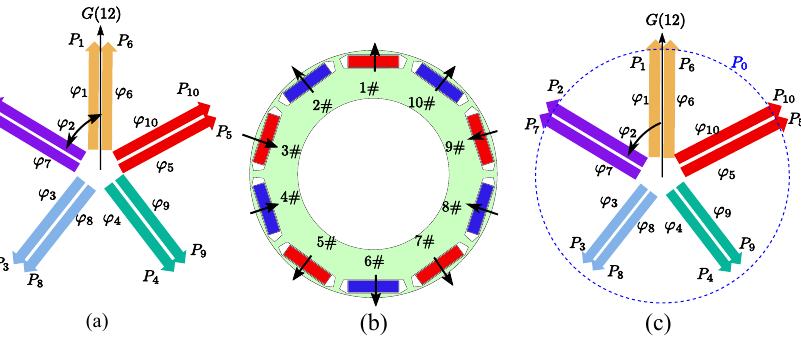
Figure 2. The PM uncertainties and the corresponding vector diagram for the additional 12th cogging torque. ( a ) The vector diagram of ideal-case; ( b ) the B r uncertainties on each PM, where the outward- pointing arrow indicates a positive uncertainty ( ∆ B r ), and the inward-pointing arrow corresponds to the negative value ( − ∆ B r ); ( c ) the vector diagram considering the effects of uncertainties, where the blue dash line represents the reference magnitude of vectors without